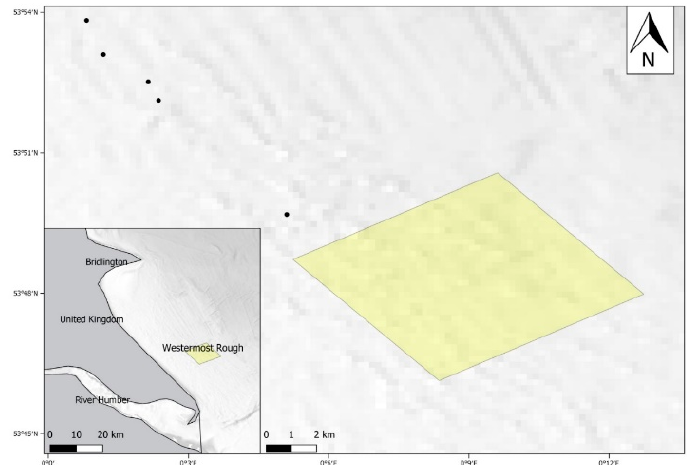
Figure 5. Map of array deployments (black points 1–5) relative to Westermost Rough offshore wind farm and Bridllington Harbour.